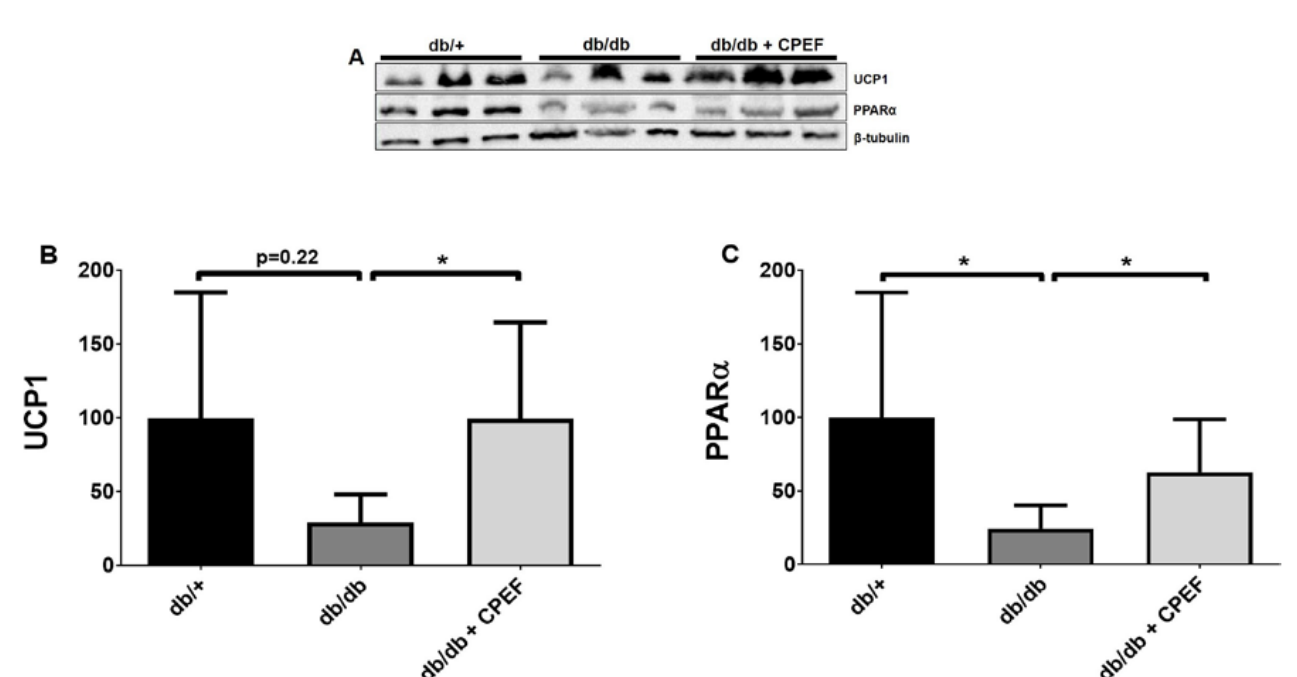
Figure 1. Treatment with CPEF increased UCP1 and PPAR α expression in brown adipose tissue of db/db mice. ( A ) Representative western blots of UCP1, PPAR α , and β -tubulin in brown adipose tissue of db/+ mice, db/db mice and db/db mice treated with CPEF. ( B , C ) Quantitative protein expression of UCP1 and PPAR α . Mice were treated with the vehicle control or CPEF (351.5 mg/kg) daily for 28 days. Protein expression was normalised to β -tubulin and data are expressed as a percentage relative to db/+ mice, which was set at 100%. Data are represented as the mean ± SD ( n = 6). Statistical significance between the groups is denoted as * p < 0.05 compared to the db/db control group.